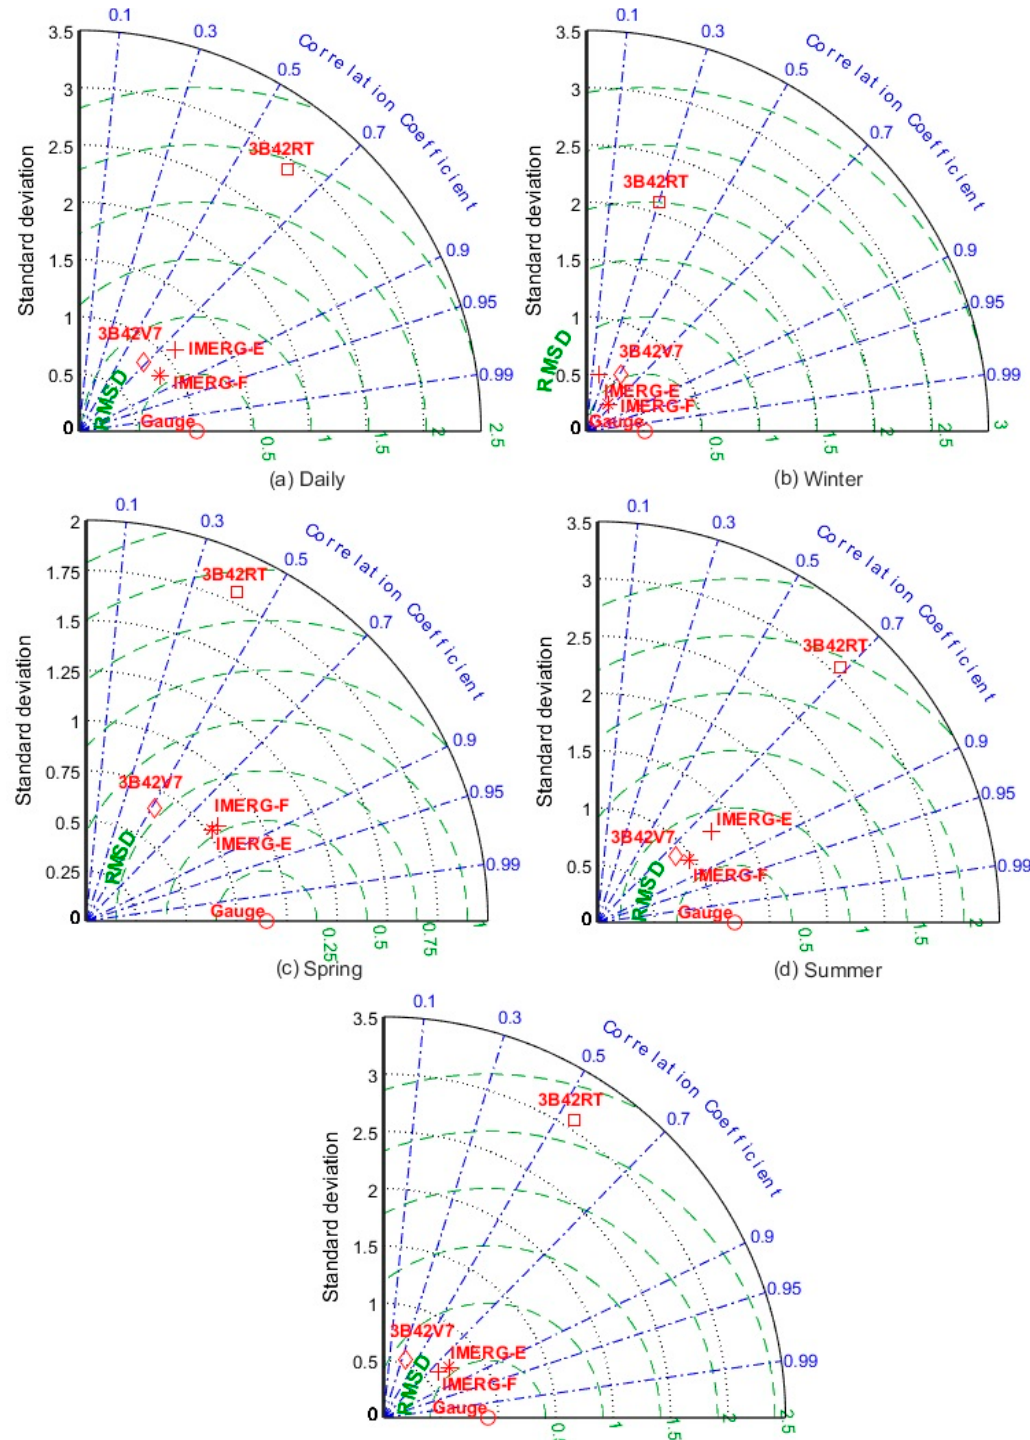
Figure 4. Taylor Diagrams of IMERG-E, IMERG-F, 3B42V7, and 3B42RT illustrating the statistical comparison with the gauge-based daily data during the entire investigation period and different seasons. ( a ) Daily; ( b ) Winter; ( c ) Spring; ( d ) Summer; ( e ) Autumn.